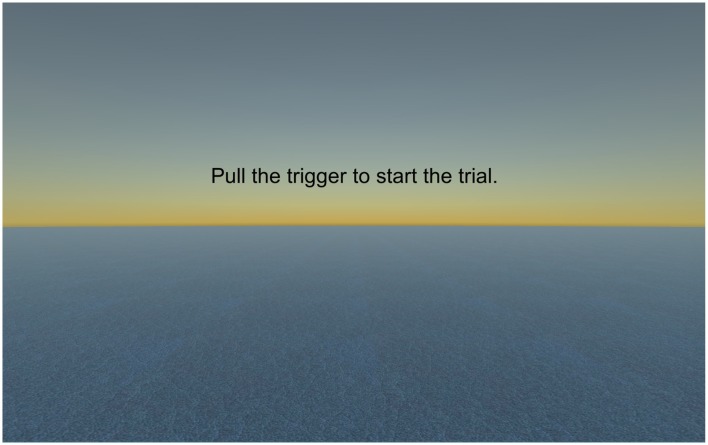
Participants’ initial view in the testing phase in Experiment 3.